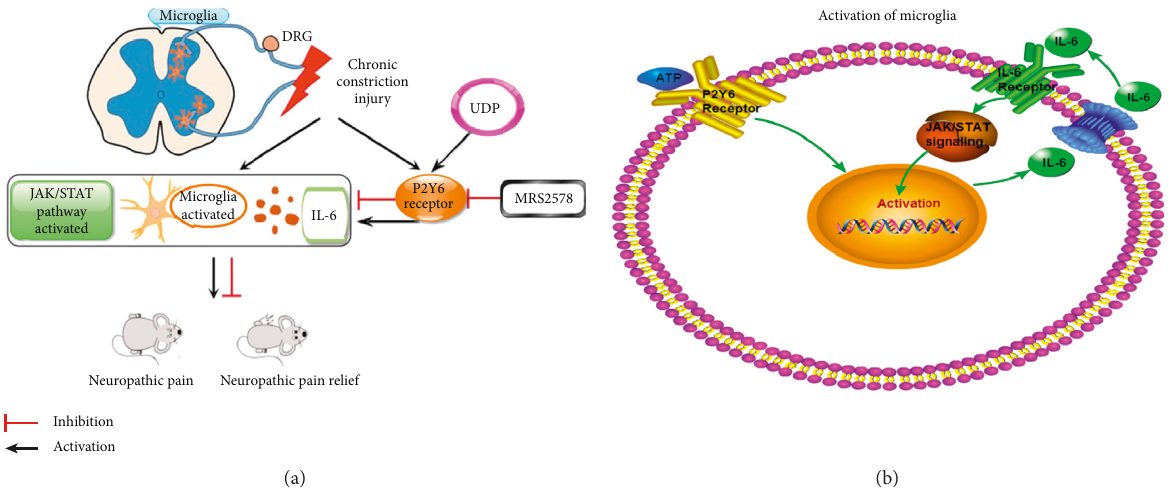
Figure 5: Schematic model of CCI in inducing the activation of microglia and NP. (a) Rats suffered from mechanical allodynia and thermal hyperalgesia after the CCI operation, along with the overexpression of P2Y6 receptors in spinal microglia, which involved in the activation of microglia by prompting the release of IL-6. Accordingly, IL-6 could induce the activation of JAK/STATsignaling in microglia. (b) Activation of P2Y6 resulted in boosted secretion of IL-6, which in turn activated the JAK/STATpathway, further activating the microglia in secreting more IL-6. It finally formed a positive-feedback